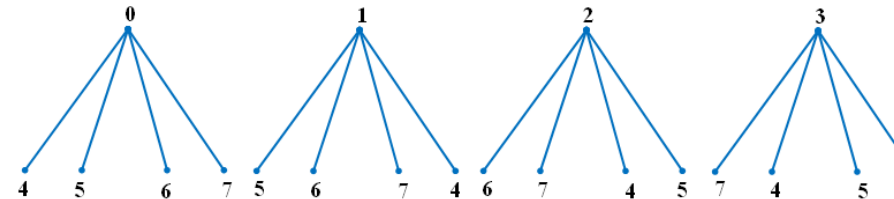
Figure 2. The labeling of the circulant graphs 𝐶 8,4 and 𝐶 10,5 .